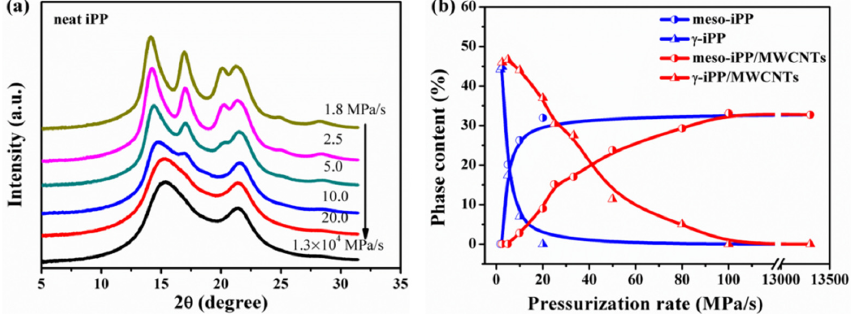
Figure 5. ( a ) Selected 1D WAXD profiles of iPP samples pressurized to 2.0 GPa at different pressurization rates; ( b ) contents of mesomorphic, and γ -phases as a function of pressurization rate.